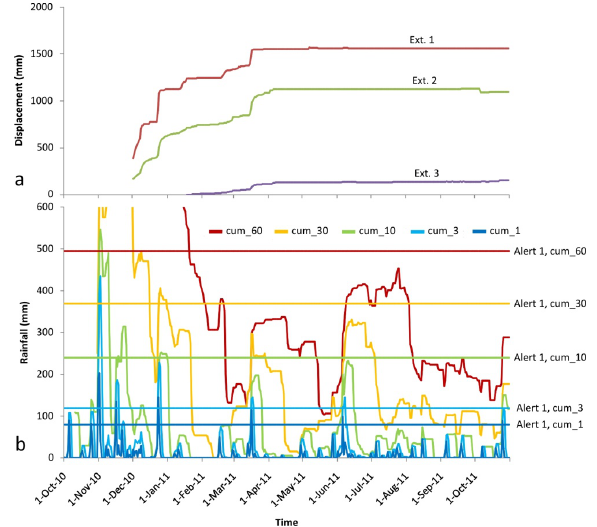
Fig. 16. Displacements measured after Val di Maso landslide by extensometers placed in the crown area (a) and variation of rain- fall cumulated over 1, 3, 10, 30, 60 days. The straight lines (in panel b ) indicate the minimum alert (return period = 2yrs) set for each variable in the hydrological alert model developed for Val di Maso (Fig. 15). Figure 17